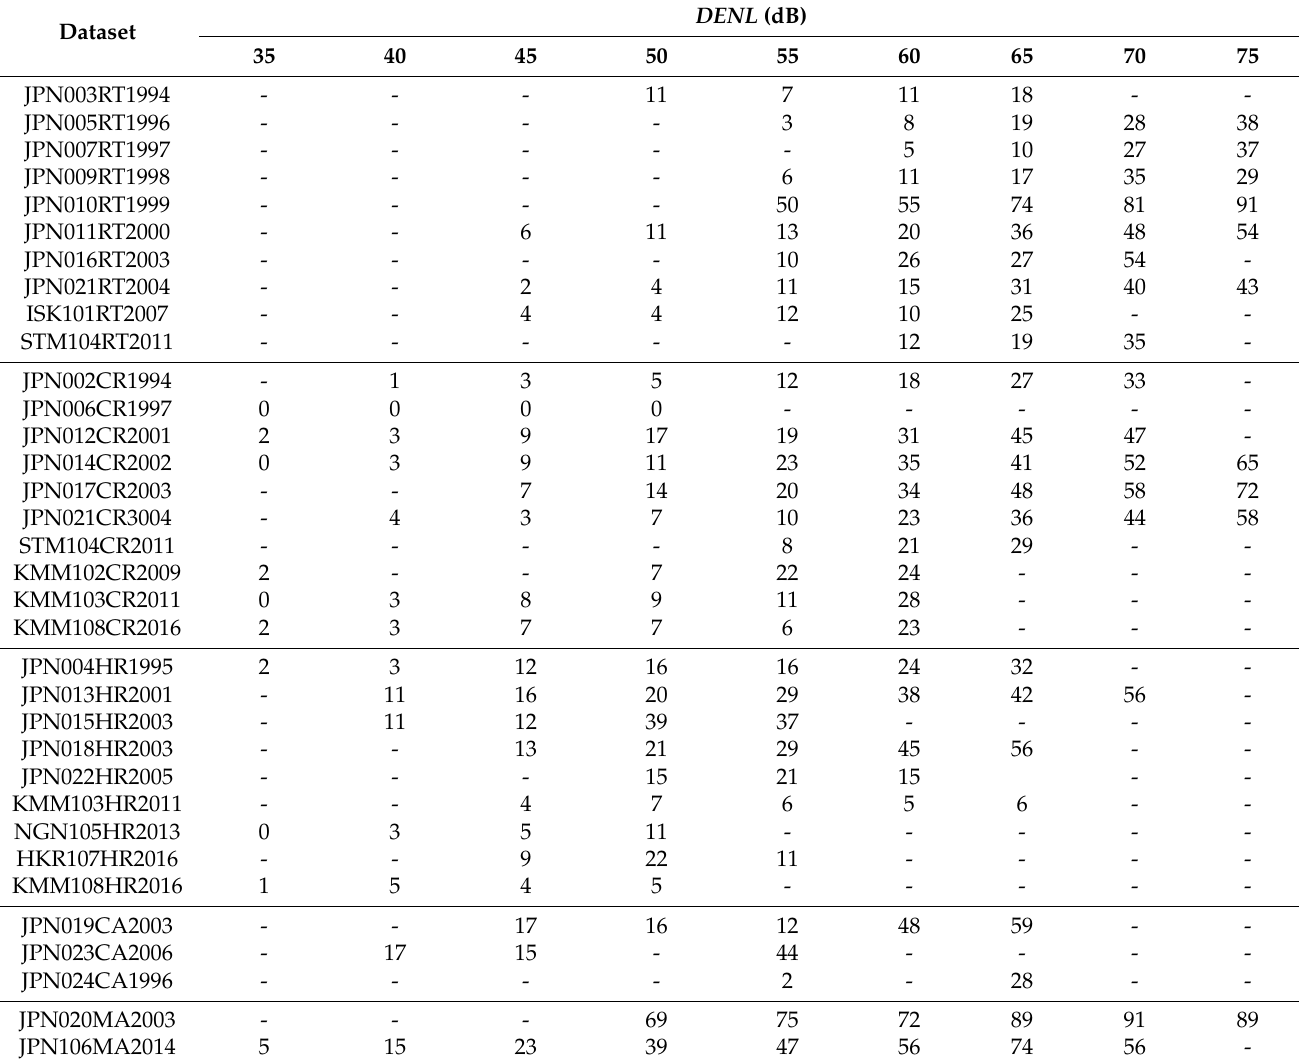
Table 6. %HA as a function of DENL (5-dB step in L den ) for each